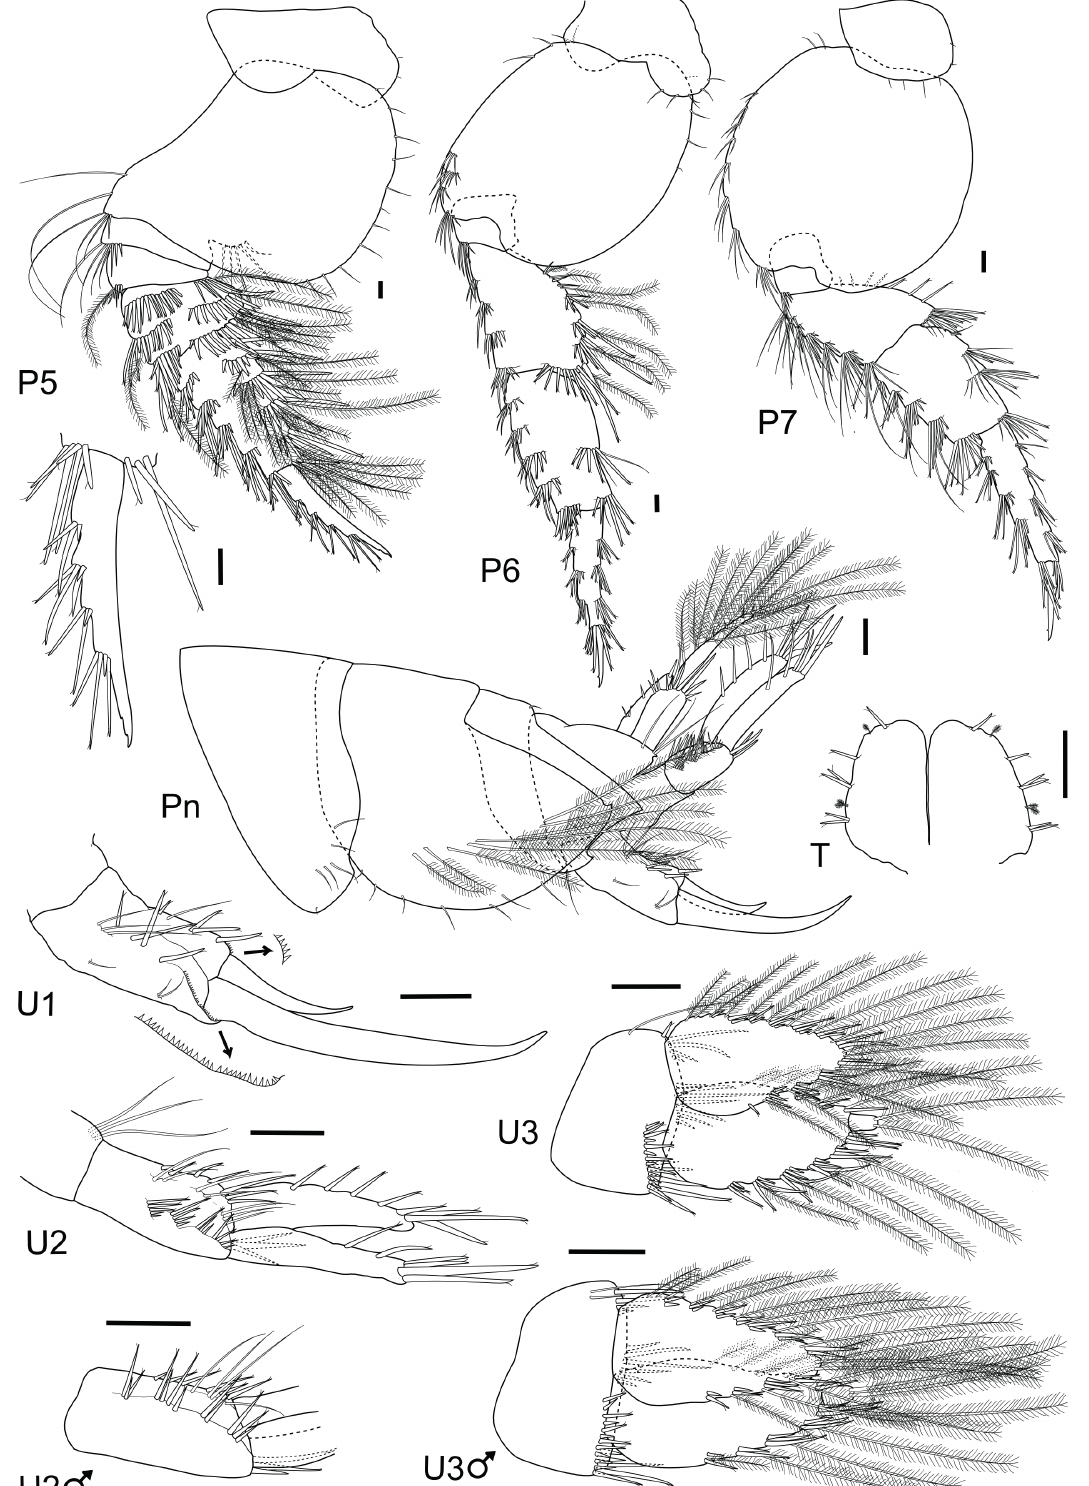
Figure 3 - Phoxocephalopsis ruffoi sp. nov. Female, 7.5 mm, MNRJ 22101: Pereopods 5 - 7, pleon, uropods and telson. Male, 6.9 mm, MNRJ 28745: Uropods 2 - 3. Scales = 0.1